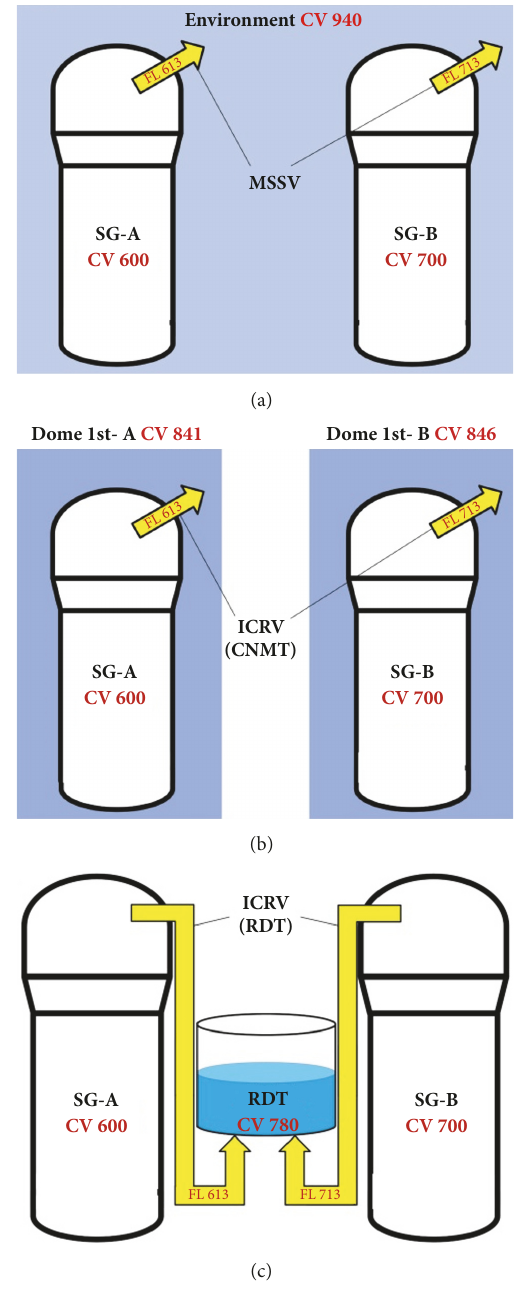
Figure 5: Schematic of simulation cases: (a) base case, (b) ICRV- CNMT case, and (c) ICRV-RDT